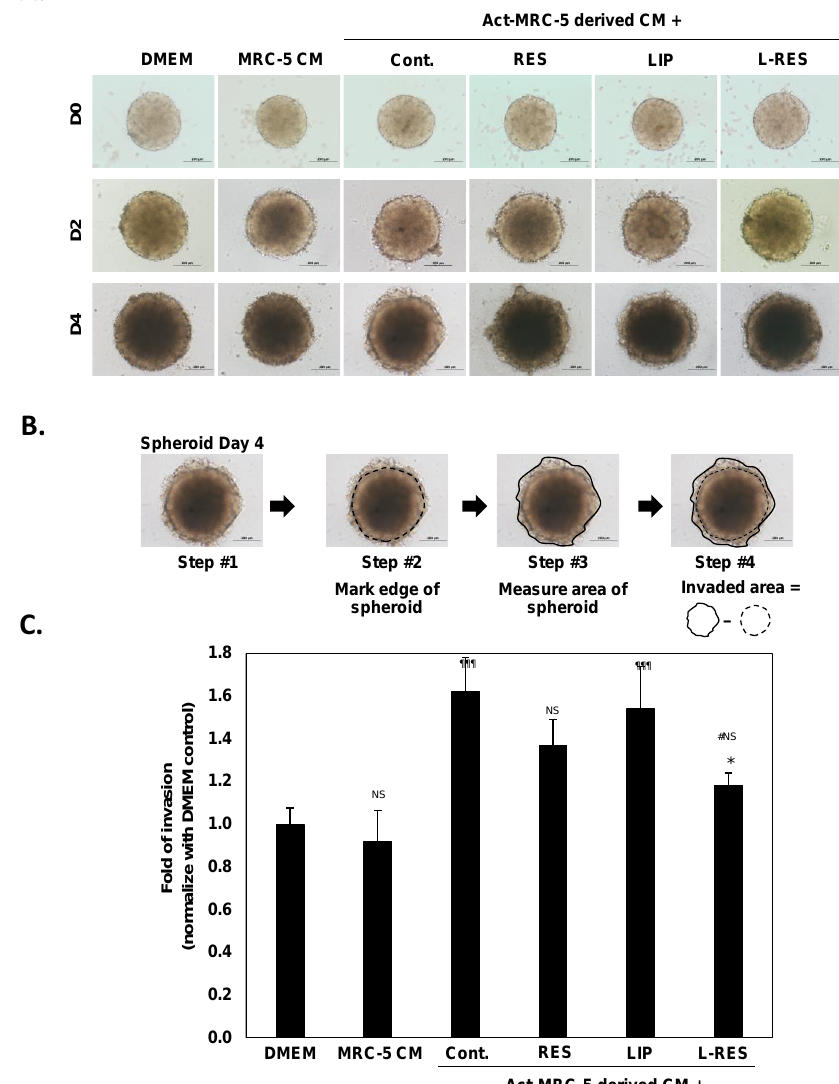
Figure 6. L-RES treatment alleviated the cancer cell invasion promoting activity of activated fibroblasts in 3D tumor spheroid invasion assay. The HT-29 tumor spheroids were established. Three-day-old spheroids were embedded in Matrigel for exploring the invasion ability of the tumor spheroid. Then, RES-, LIP-, or L-RES-treated Act-MRC-5-derived CM was added into the spheroid for 96 h, and the invaded area was examined. ( A ) Morphology of HT-29 tumor spheroid invasion observed under inverted microscope at 10× magnification. ( B ) Calculation method of invaded area using ImageJ software. ( C ) The relative invaded area from the edge of the spheroid determined by ImageJ software (untreated control cells = 1). The data are means ± SD from the representative experiments. * p < 0.05 vs Act-MRC-5 control. ¶¶¶ p < 0.001 vs DMEM control. NS: nonsignificant.